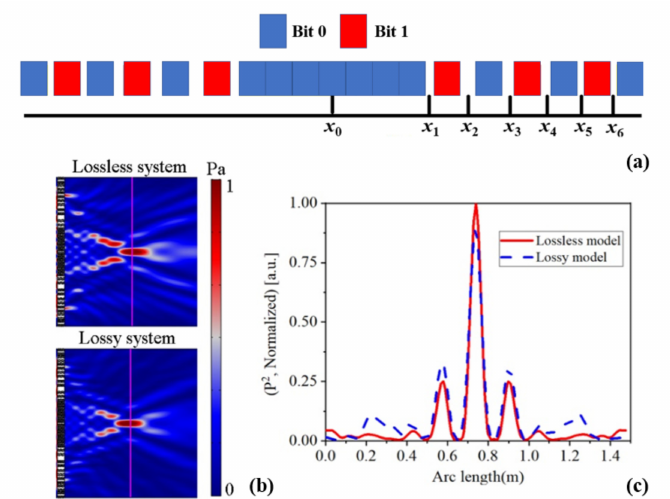
Figure 6. ( a ) The schematic diagram of the coding lens; ( b ) Acoustic focusing in lossless system and lossy system at 3430 Hz; ( c ) Pressure profile along the cut-line in two